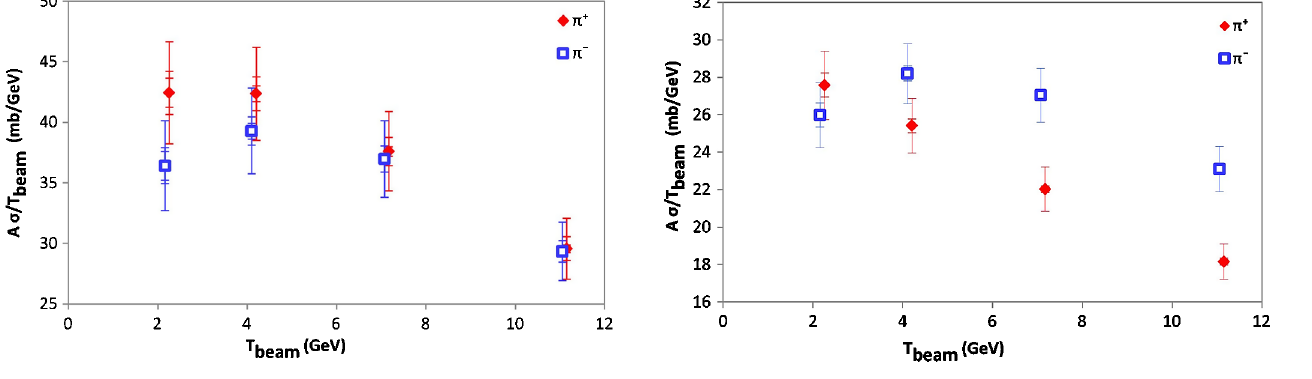
FIG. 5. Acceptance-weighted cross sections, divided by beam energy, for (cid:3) þ and (cid:3) (cid:1) production by protons off of tantalum, using data from the HARP-CDP group. The points for (cid:3) þ and (cid:3) (cid:1) have been displaced, respectively, left and right by 50 MeV for clarity of